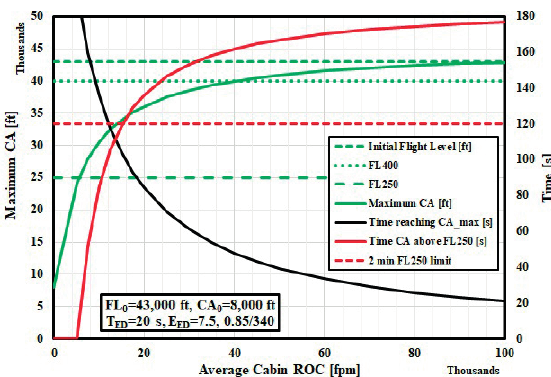
Fig. 6. ED computations for a subsonic airplane flying initially at FL430 with the CA of 8,000